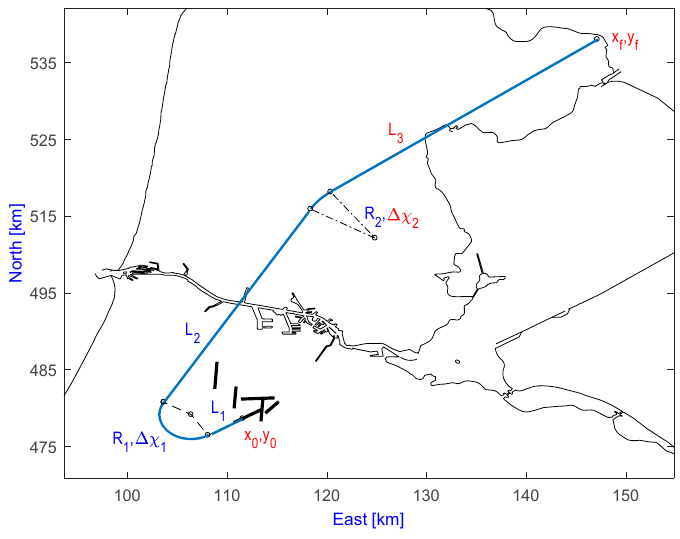
Figure 1. Ground track parameterization.